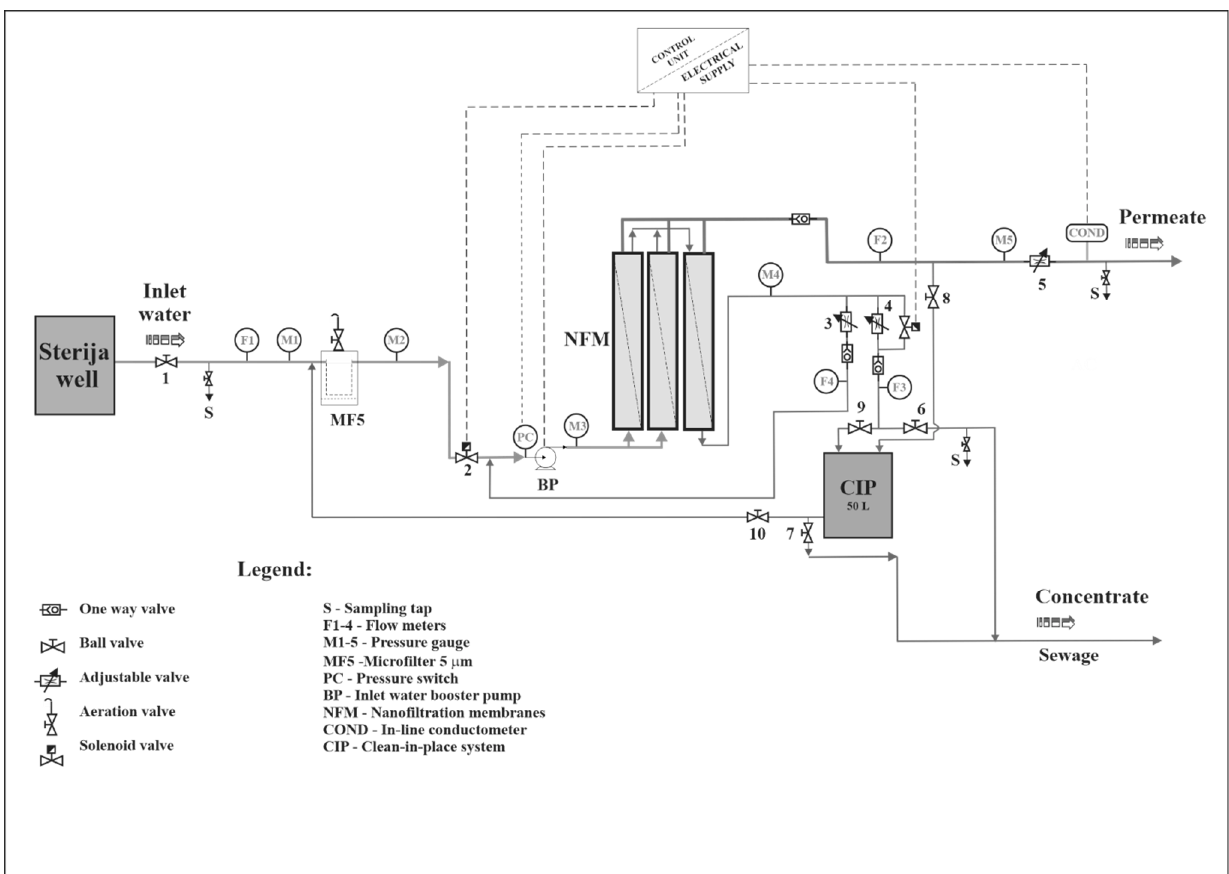
Figure 1. Schematic of the pilot plant. Three membrane combinations were selected for the investigation purposes, which represent different experimental series (Table 3). Effective pore radii (r E ) in nm of the membrane systems were calculated at the base of the empirical correlation between r E in nm, and membrane combination molecular weight cut-off (MWCO) in Da [30]: